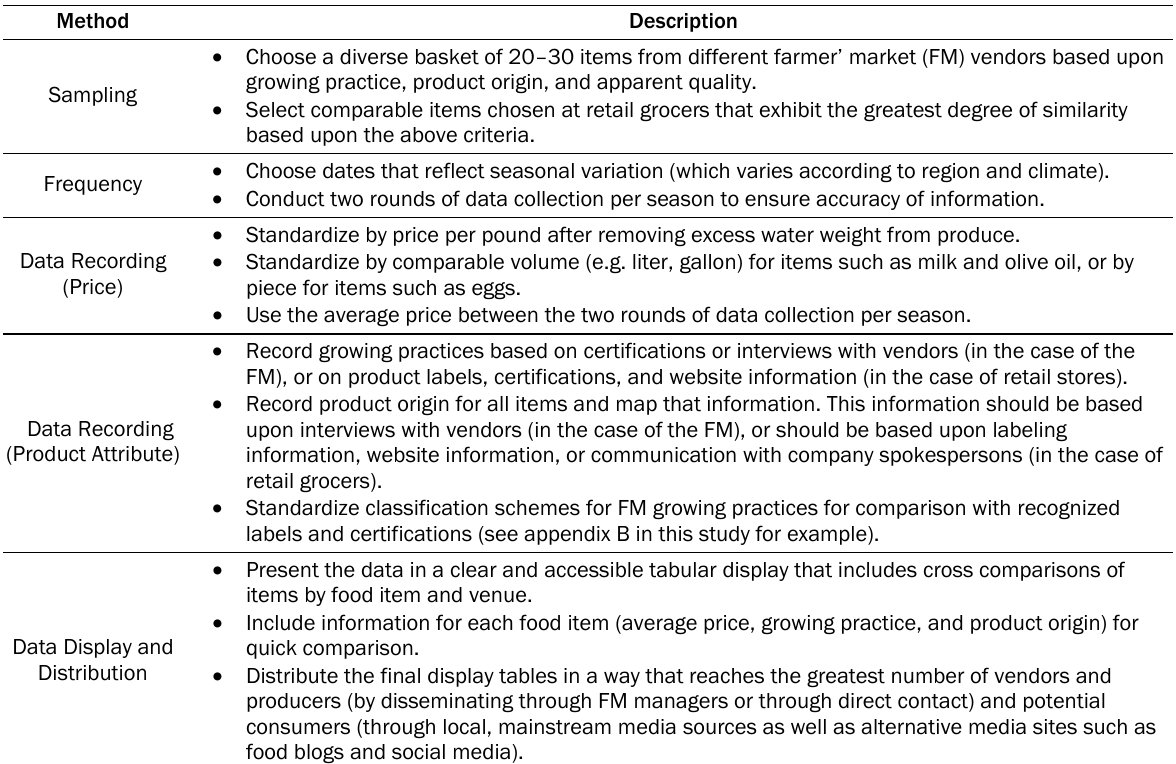
Table 3: An Improved Model for Local Price Comparison